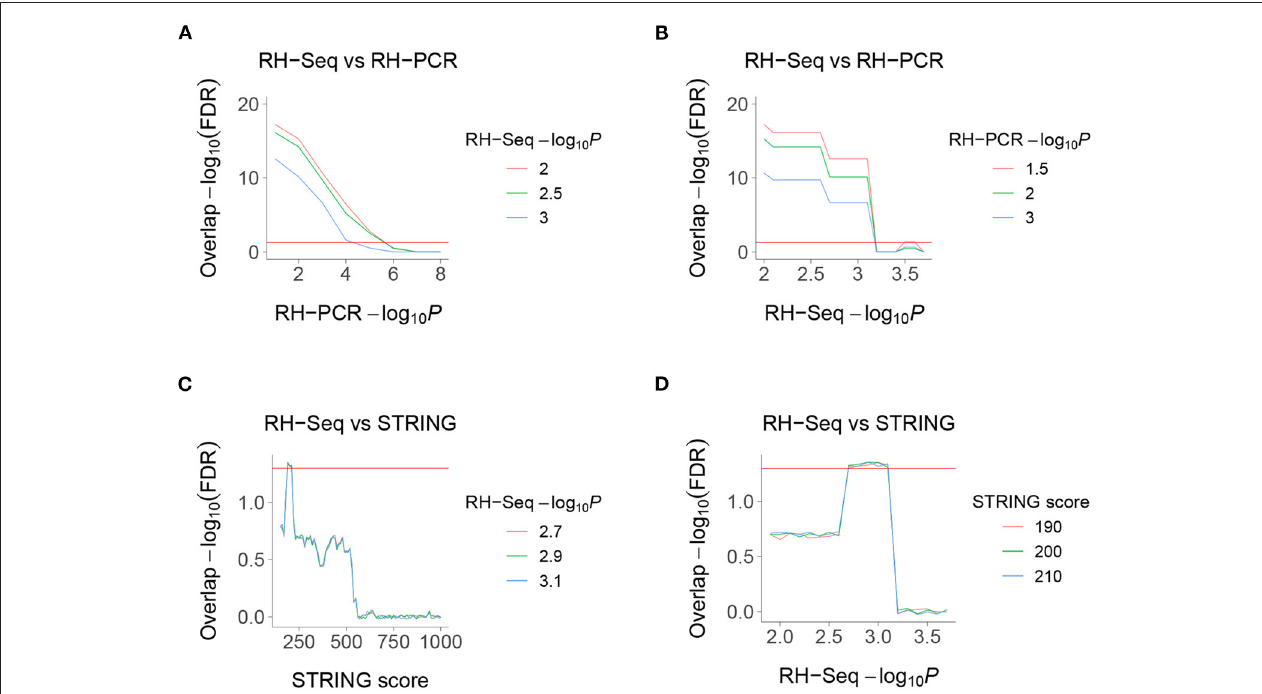
FIGURE 4 | Overlaps of RH-Seq network. (A) Overlap of RH-Seq and RH-PCR networks, thresholded on RH-PCR − log 10 P (abscissa). (B) Overlap of RH-Seq and RH-PCR networks, thresholded on RH-Seq − log 10 P . (C) Overlap of RH-Seq and STRING interactions, thresholded on STRING score. (D) Overlap of RH-Seq and STRING interactions, thresholded on RH-Seq − log 10 P . Horizontal red lines, FDR =